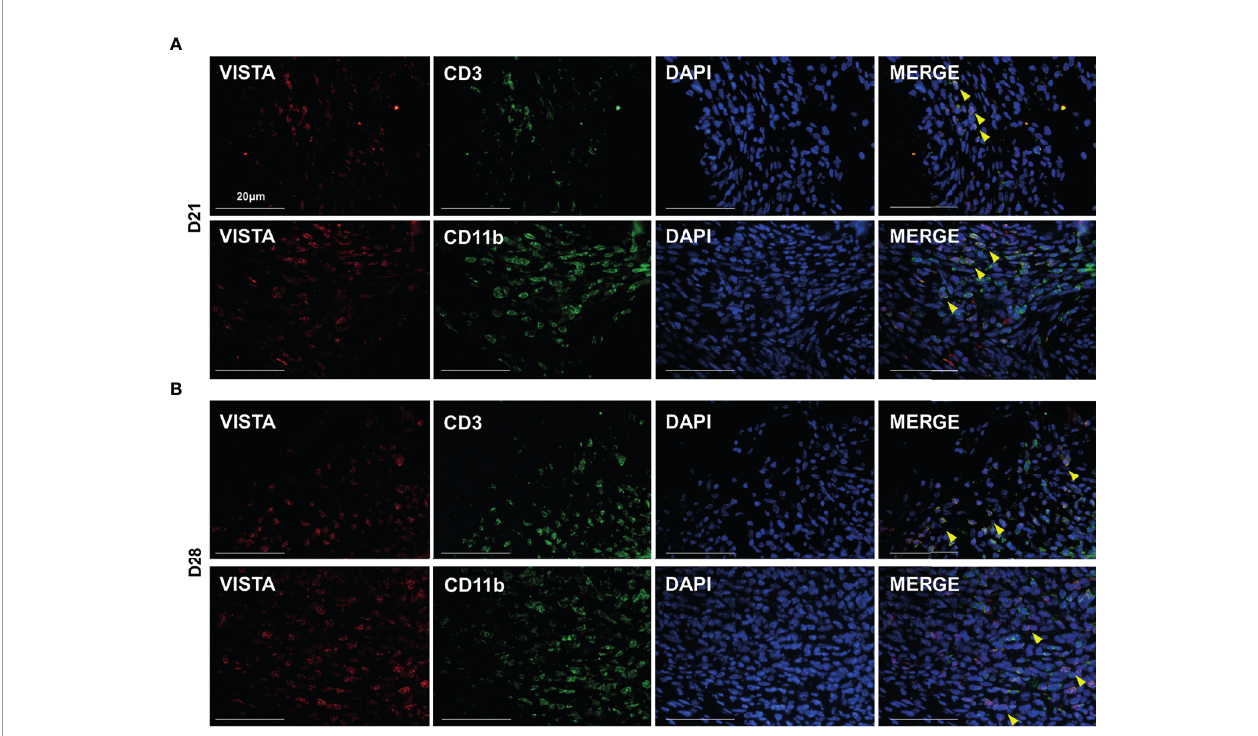
FIGURE 3 | VISTA was expressed on both myeloid cells and T cells in mouse experimental apical periodontitis. Colocalization staining of VISTA/CD3 and VISTA/ CD11b at different time points in experimental apical periodontitis tissues (n=5). (A) 21 days after the mice underwent the pulp exposure procedure and (B) 28 days after the procedure. Scale bars=20 m